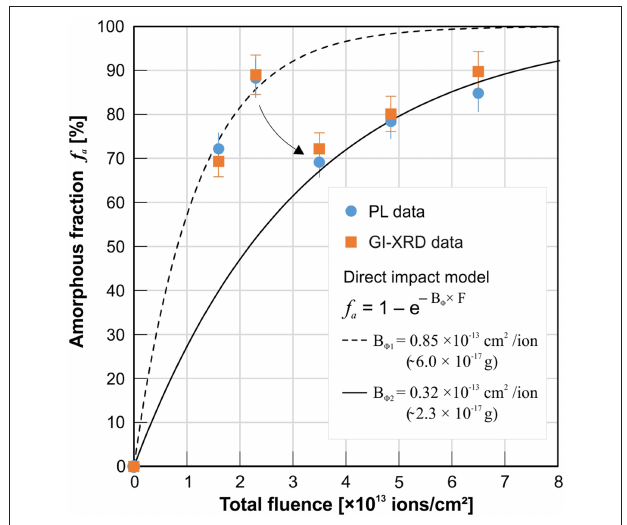
FIGURE 8 | Summarized data from PL and GI-XRD measurements of heavy-ion (Au) irradiated YPO 4 ceramics: The amorphous fraction f a of the irradiated surface unto a depth of 1.5 µ m as obtained from the two independent methods plotted against the applied total fluence (see details on irradiation energies used in Figure 1 ; see detailed data in Table 2 ). Both methods give comparable f a values with respect to their error margins. Note, that radiation-damage does not accumulate continuously with increasing fluence. At high radiation damage levels as accumulated > 2 × 10 13 ions/cm 2 , a sudden set-back accompanied with a less effective accumulation behavior was registered